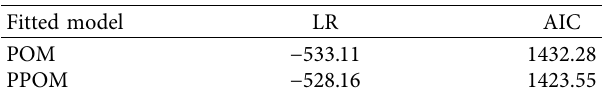
Table 4: A comparison of the developed ordinal logistic regression